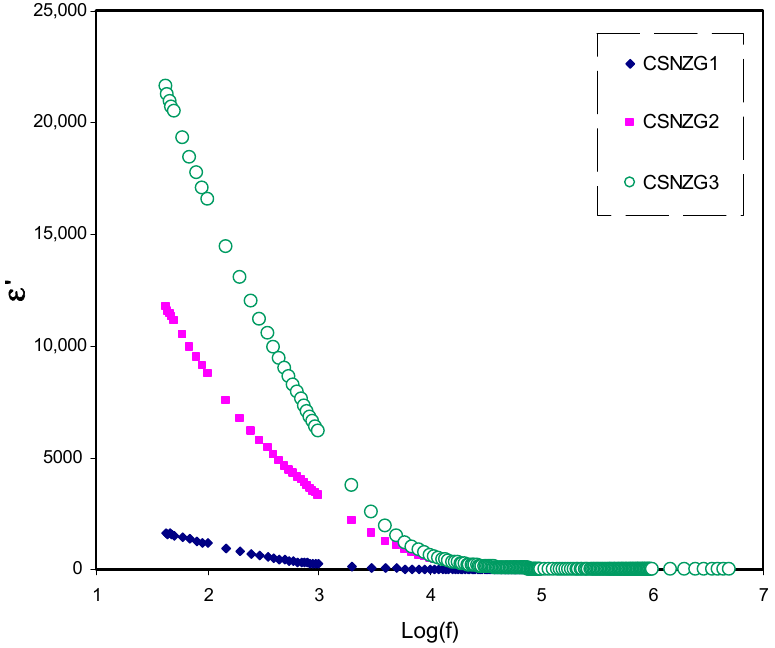
Figure 5. Variation of dielectric constant ( ε′ ) versus frequency for the CSNZG1, CSNZG2, and CSNZG3 composite electrolyte samples at room temperature.